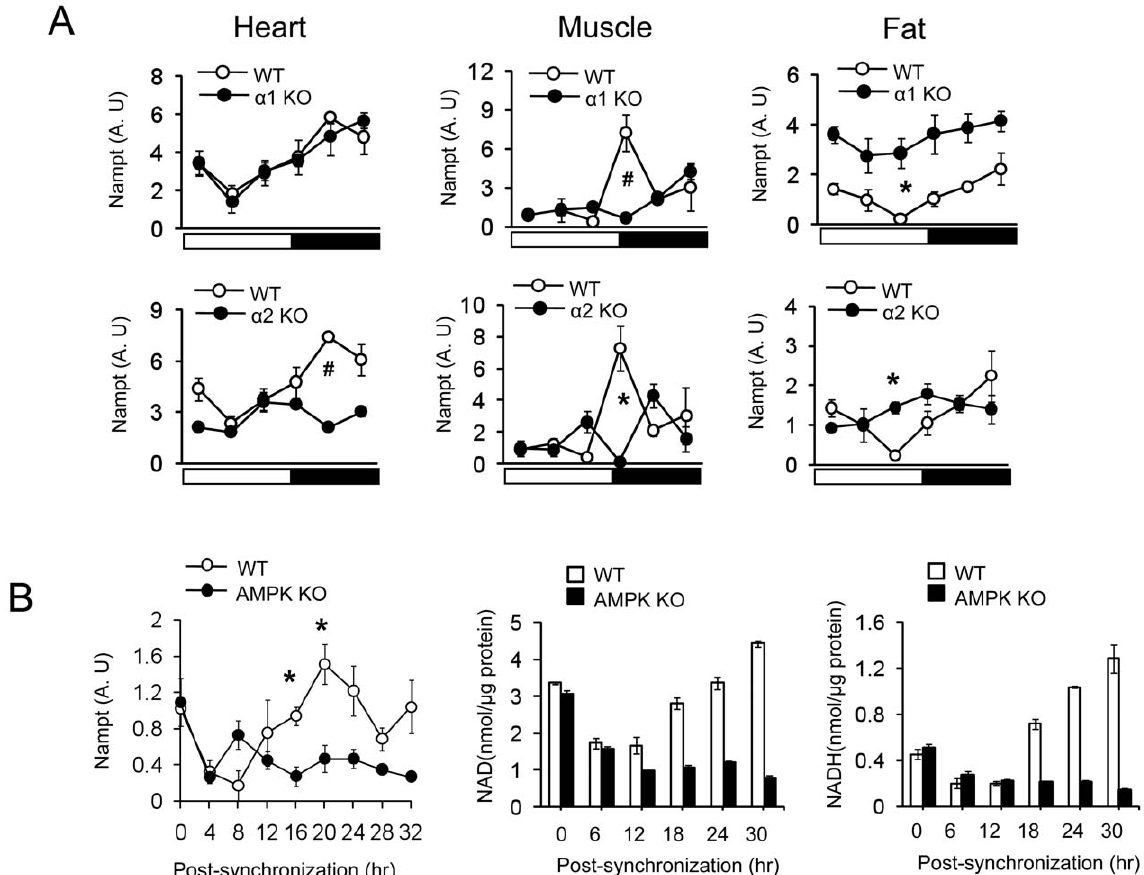
Figure 6. Circadian oscillation of NAD + and Nampt gene expression requires AMPK. (A) Nampt gene expression patterns of heart, skeletal muscle and fat tissue during 24 hr for AMPK a 1 2 / 2 , AMPK a 2 2 / 2 and WT mice. The relative levels of mRNA are presented in arbitrary units. Results are expressed as mean 6 S.E., * P , 0.05, # P , 0.001 between WT and AMPK a deficient mice. (n=4–5 for each time point). The same WT data is plotted for a 1 KO and a 2 KO. (B) Nampt gene expression (arbitrary units) and cellular NAD + and NADH level in WT and AMPK a 1/ a 2 KO mefs synchronized with forskolin. Results are expressed as mean 6 S.E., * P , 0.05, between WT mefs and AMPK a 1/ a 2 KO mefs (n=3).